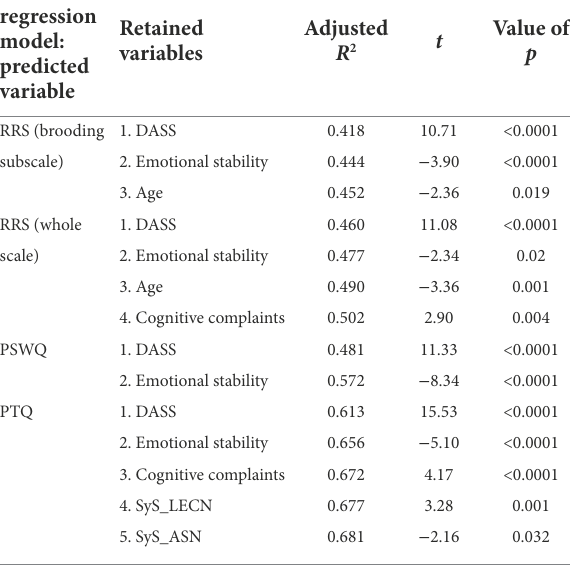
TABLE 3 Variables entering each regression models conducted for every component of RNT, separately. Linear regression model: